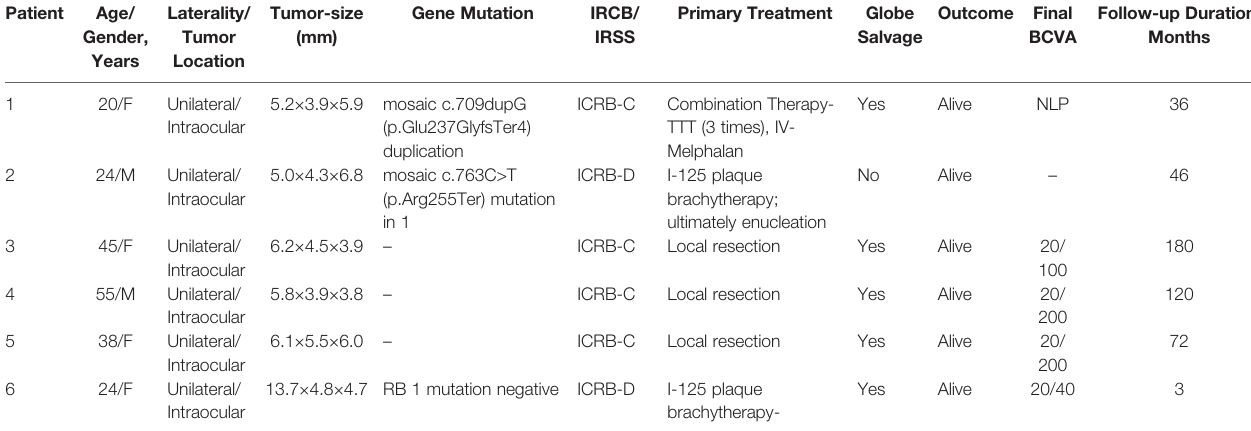
TABLE 1 | Active retinoblastoma in adults: a study of 6 Cases.